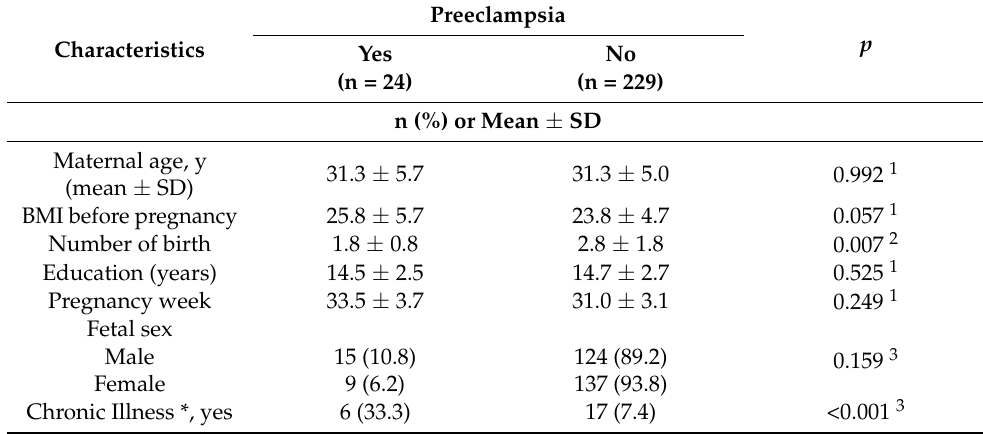
Table 1. Background socio-demographic and health characteristics of the study population.